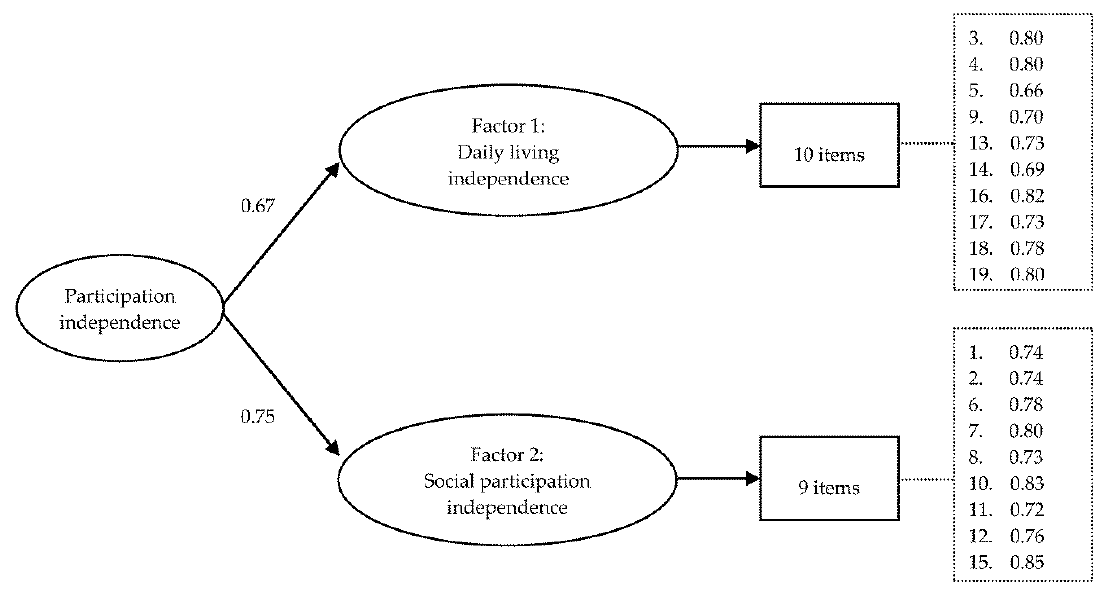
Figure 2. Second-order confirmatory factor analysis model of the independence dimension of the participation part of the Functioning Disability Evaluation Scale-Child version ( n = 4823).